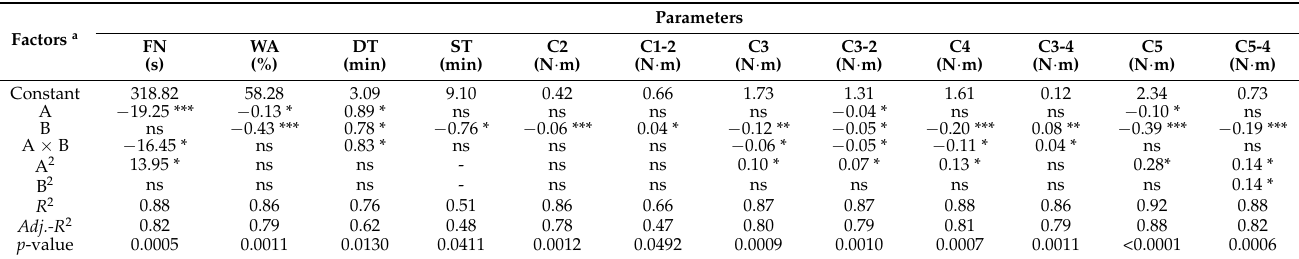
Table 3. The coefficients in the predictive models for FN index and dough rheological properties during mixing and heating process of buckwheat-wheat flour